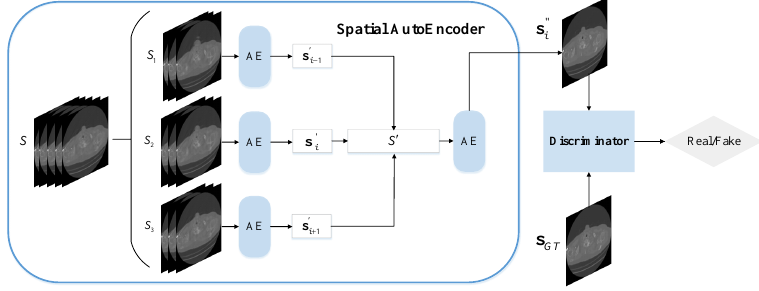
Figure 5. The overall architecture of our proposed Spatial-AAE in stage two.